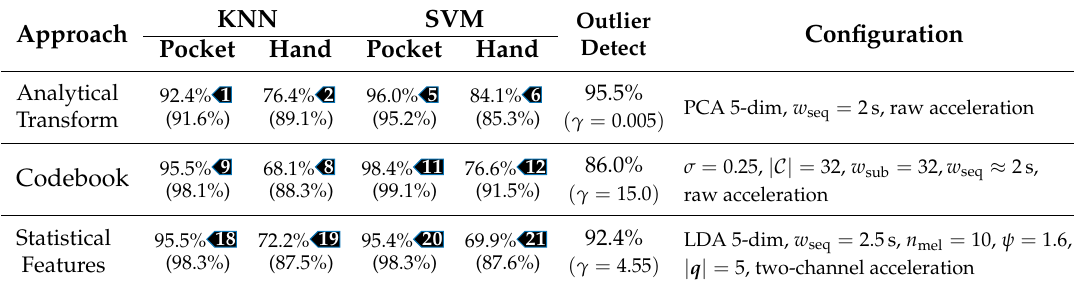
Table 3. Overview of all final benchmark results with average classification accuracy and average F1-score (in brackets) for the chosen configuration of each approach. The last column shows the configuration’s hyperparameters, as well as the γ trained for outlier